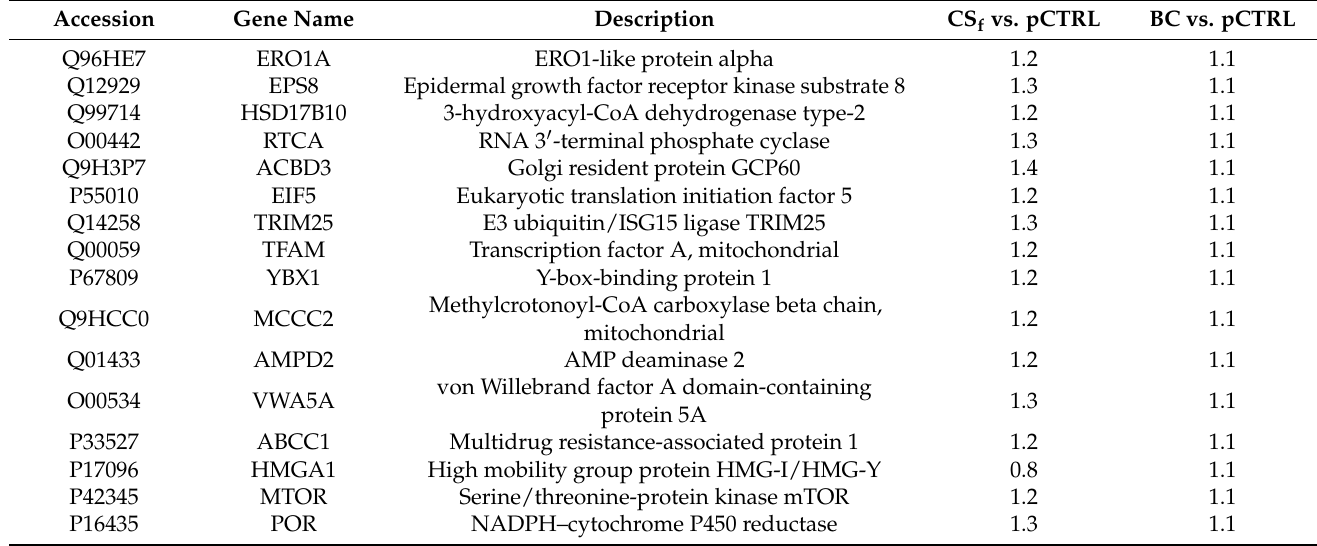
Table 3. Proteins differentially regulated (0.8 ≥ FC ≥ 1.2) in CS f - or BC-treated vs. pCTRL synovio- cytes identified by high-resolution